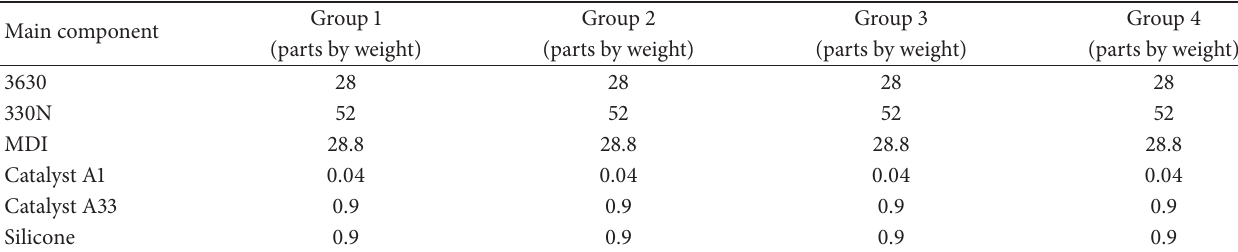
Table 2: Foam formulation and